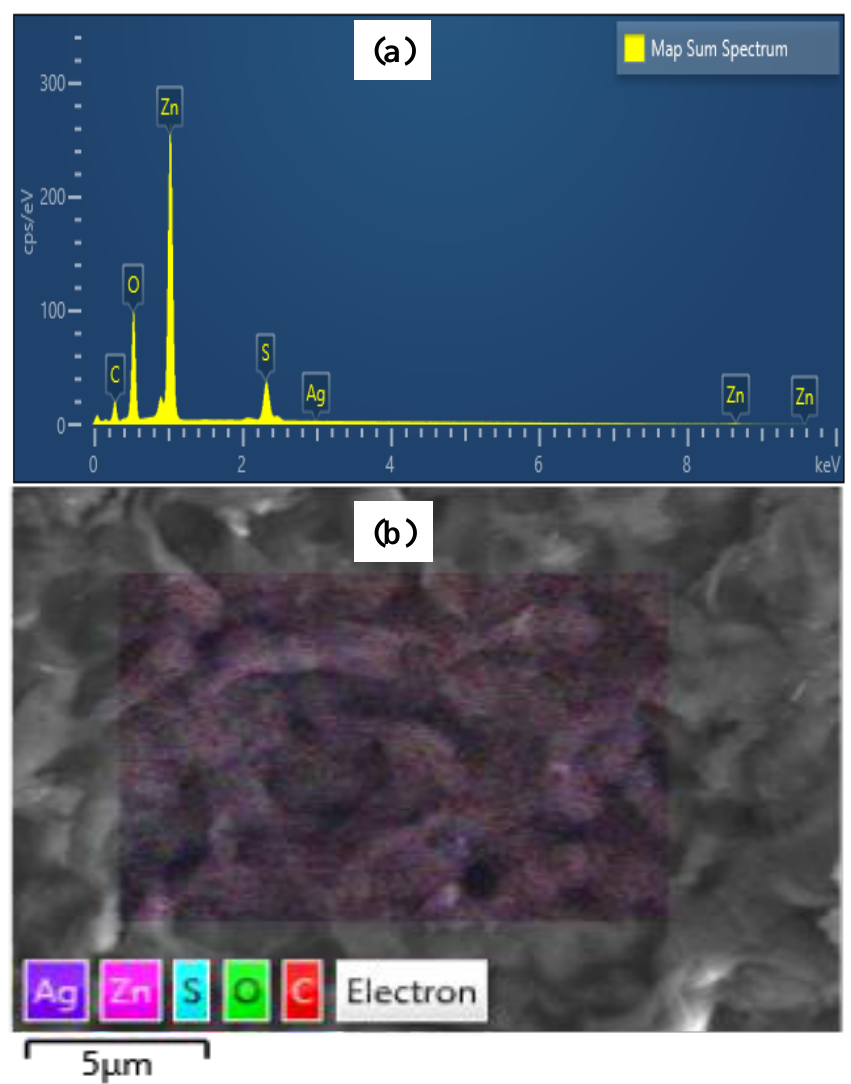
Figure 3. EDX spectrum ( a ) and SEM-EDX elemental mapping ( b ) of rGO-ZnS-Ag. FT-IR analysis of the rGO-ZnS-Ag, rGO-ZnS, and rGO in Figure 4a–c, respectively, display some characteristic peaks of the graphene oxide, i.e., 1727 cm − 1 for the C=O stretching vibration of the carboxyl moiety and 1218 cm − 1 for the C-OH stretching [30,31]. The peaks corresponding to the oxygen functionalities of GO, such as carbonyl, hydroxyl, carboxyl, and epoxy groups, disappeared completely upon reduction, whereas some other peaks underwent a substantial shift from 1048 cm − 1 to 1005 cm − 1 for the C-O stretching vibration due to the strong reduction of the graphene oxide by the N, N Dimethyl formamide, indicating the good reduction ability of the solvent [22]. Thus, DMF not only acts as a medium for nanocomposite formation, but also a reducing agent for both nanoparticles and for GO sheets. Furthermore, a new band appears at 876 cm − 1 due to the bending mode of the aromatic C-H groups on the reduced graphene surface, along with the appearance of the characteristic bands of the ZnS and Ag at 1116 and 668 cm − 1 , supported by the formation of nanoparticles over the graphene substrate [32]. A broad absorption band around 3400 cm − 1 was observed in all the three samples, which is associated with the O-H stretching vibration of the C-OH groups and the water entrapped in the structures. The absorption peaks at 1644 cm − 1 appeared due to the C=C stretching [33].